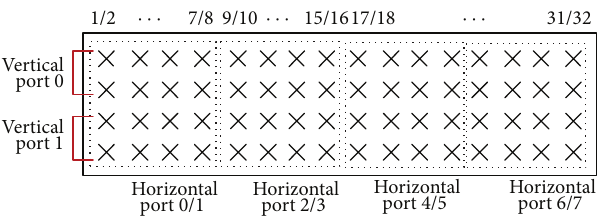
Figure 6: Antenna array with 4 × 16 X-pol elements.